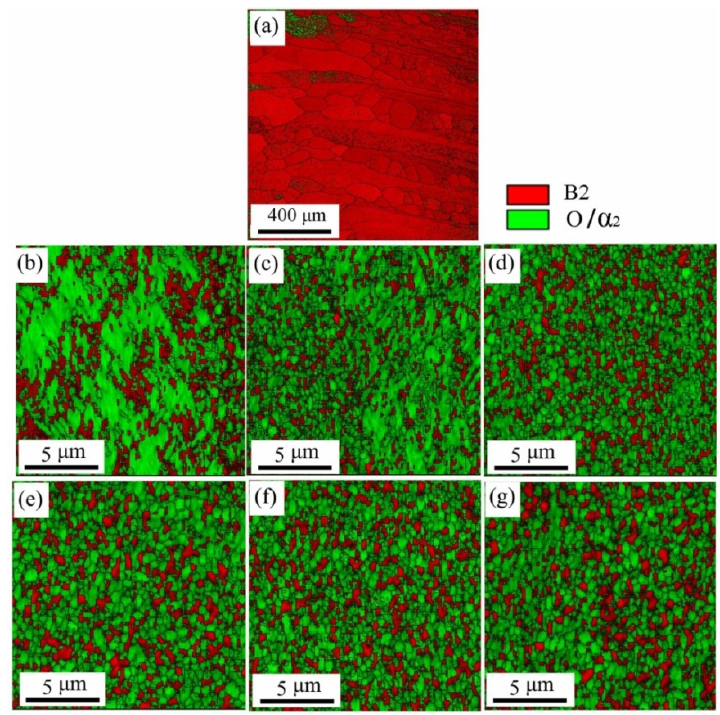
Figure 14. IQ + Phase figure of FZ of Ti2AlNb alloy spun workpiece formed at different passes: ( a ) initial welded tube, ( b ) pass 1st, ( c ) pass 2nd, ( d ) pass 3rd, ( e ) pass 4th, ( f ) pass 5th, ( g ) pass 6th.